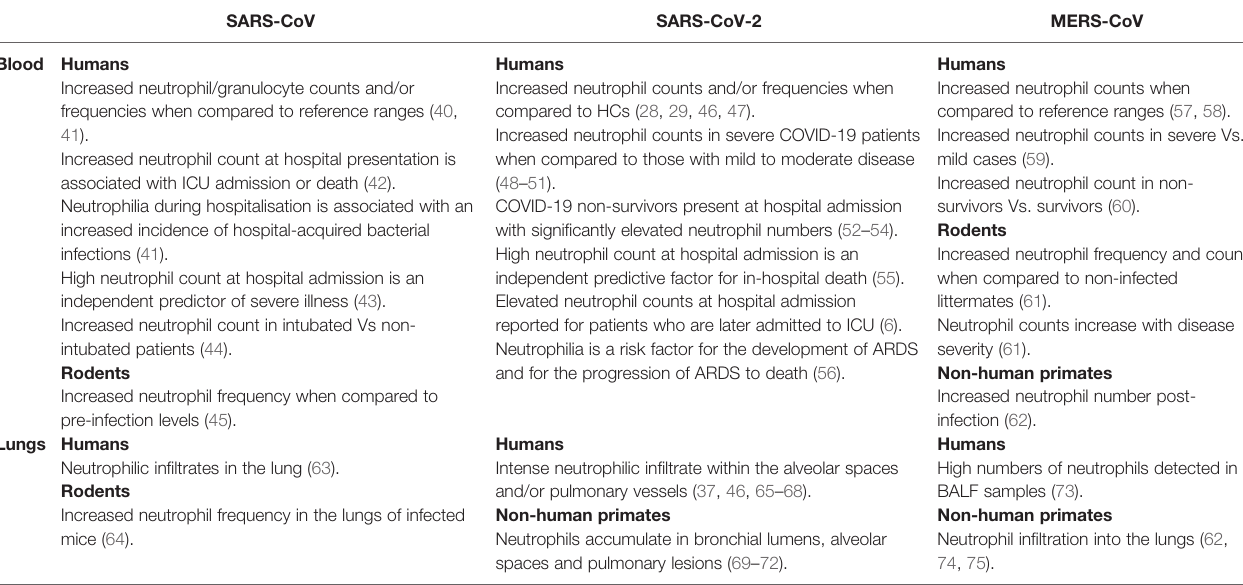
TABLE 1 | Changes reported in the number/frequency of circulating or pulmonary neutrophils in patients, rodents or non-human primates infected with SARS-CoV, SARS-CoV-2 or MERS and their relationship with disease severity or clinical outcome. SARS-CoV SARS-CoV-2